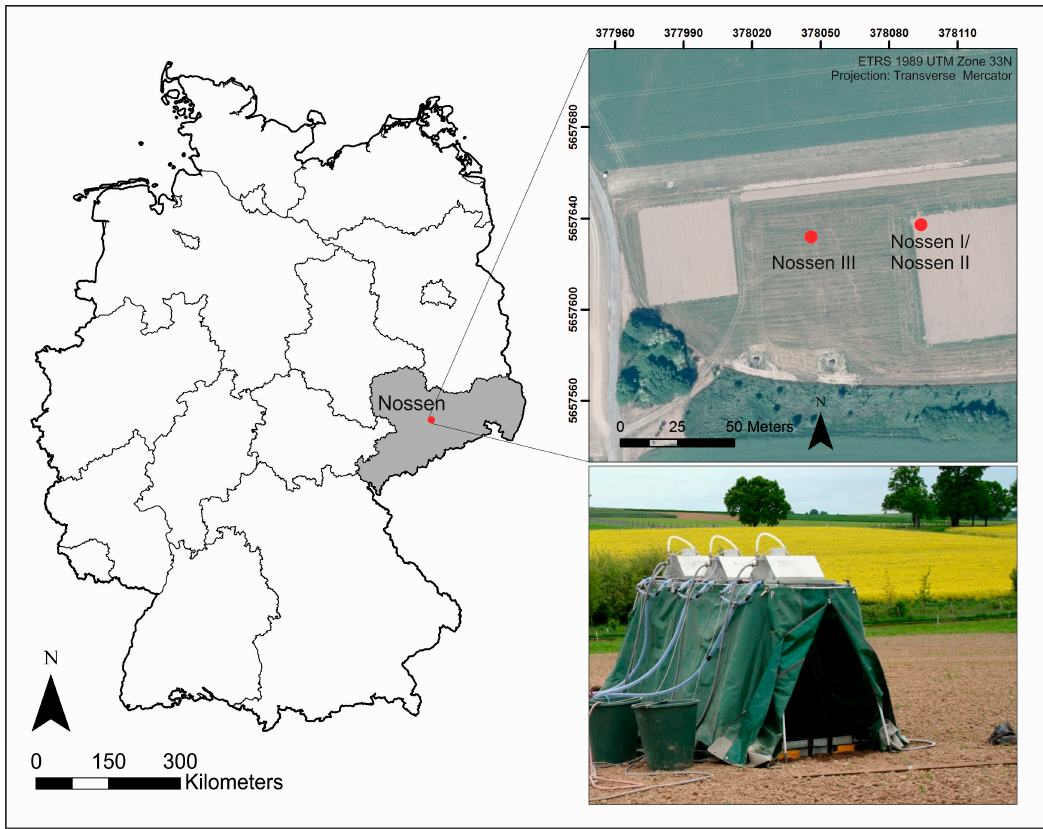
Figure 1. Sites of rainfall simulation experiments [36].